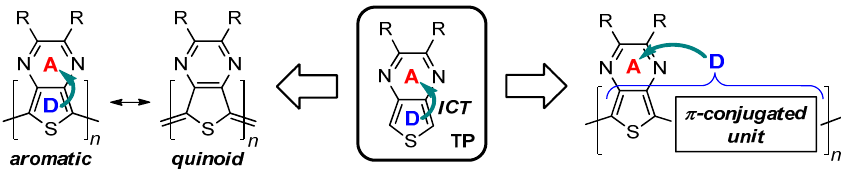
Figure 1. Monomeric thieno[3,4- b ]pyrazine (TP) and TP-based materials.